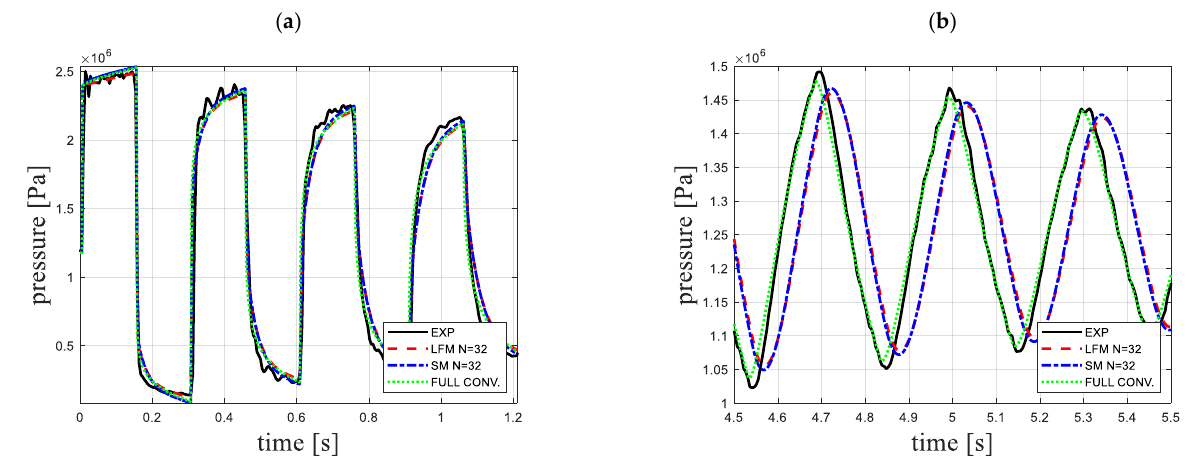
Figure 10. Results before correction of pressure wave (Case 09, Re = 15850): ( a ) initial phase; ( b ) later phase.